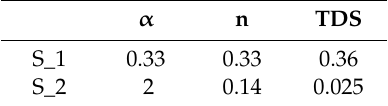
Table 5. APS optimal settings for S_1 and S_2 (Scenario B).